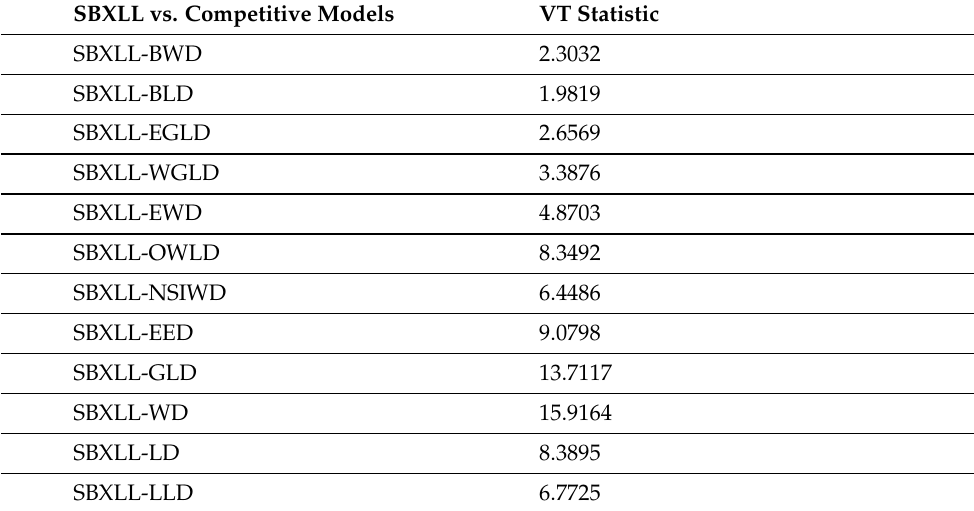
Table 24. Vuong’s test was applied on data set IV at Z 0.05 = 1.6495. SBXLL vs. Competitive Models